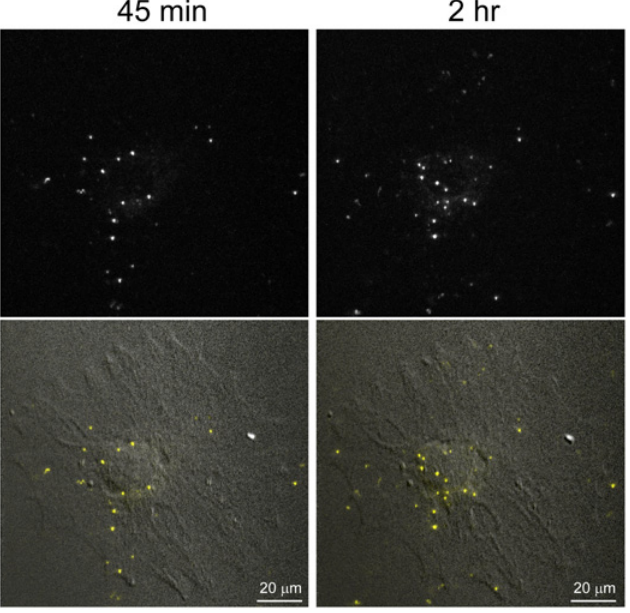
Fig 6. Analysis of 263K A647 uptake by non-neuronal cell at very early time points. Images acquired of the same non-neuronal cell at 45 min and 2 h after addition of 263K A647 . A change in the distribution of fluorescent particles was observed over time, at least some of which were intracellular. This interpretation was supported by rapid time-lapse imaging of fluorescent PrPres trafficking in the cell at 2 hpe (S2 Video).